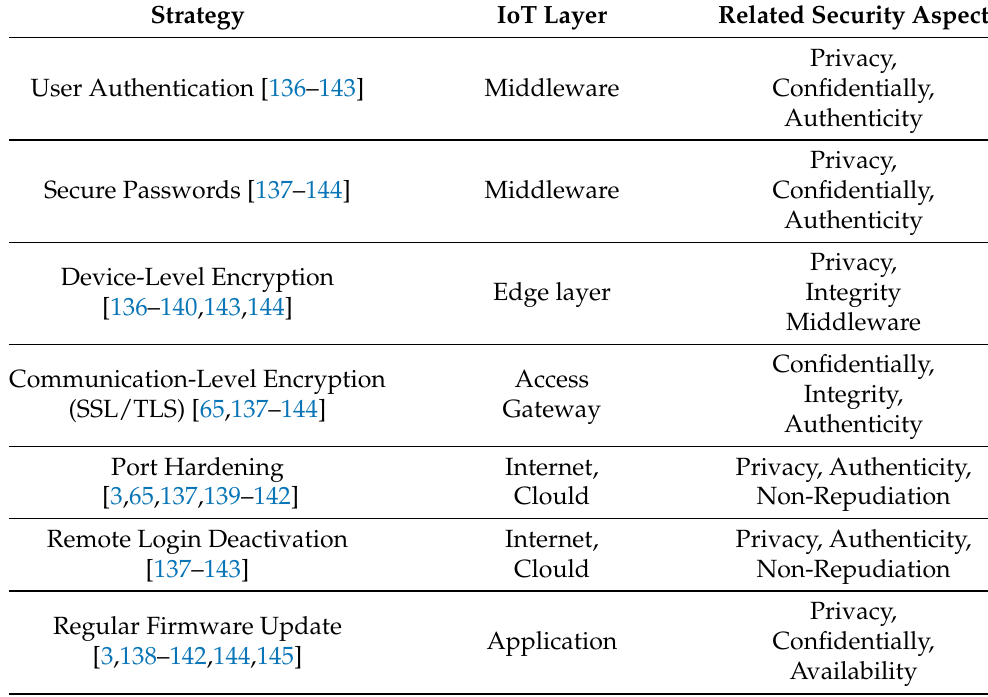
Table 2. Risk Mitigation Strategies for SF and